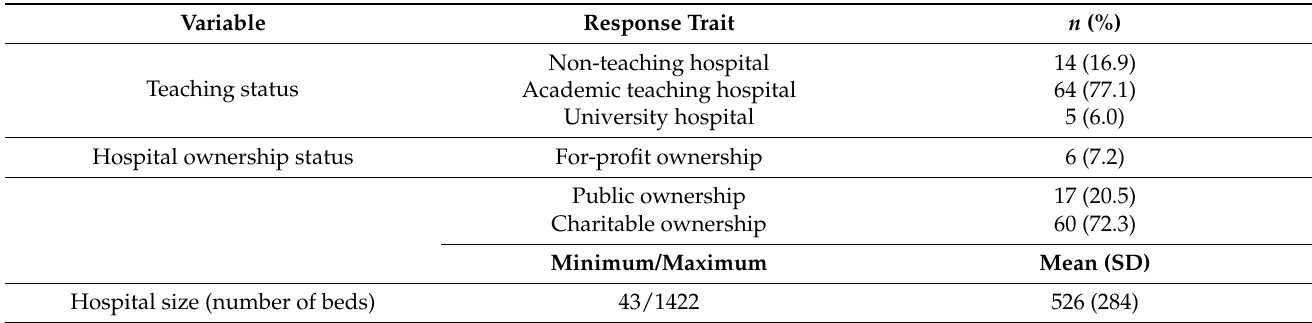
Table 3. Descriptive results of the hospital-level variables ( n =